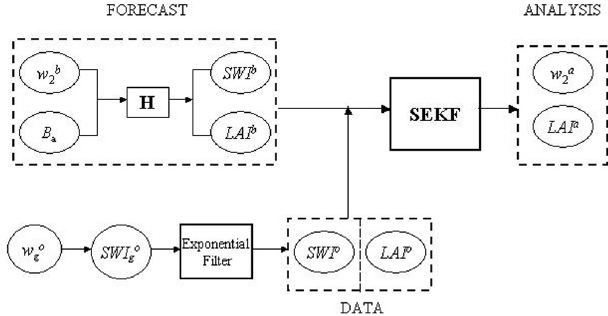
Fig. 1. The SEKF data assimilation design for LAI and SWI com- ponents. SWI o observations in the root zone are derived from nor- malized surface soil moisture SWI o g using the exponential filter.